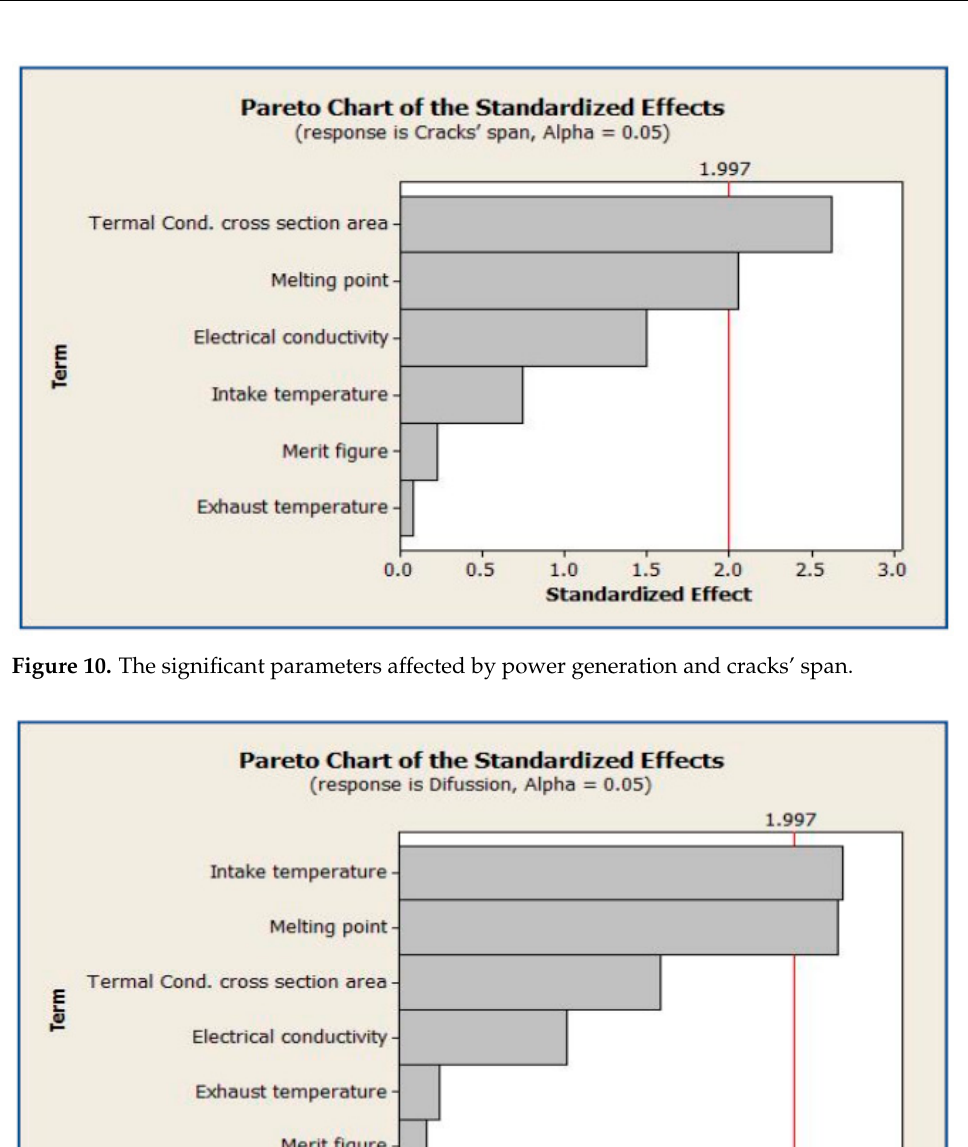
Figure 9. The significant parameters affected by power generation.